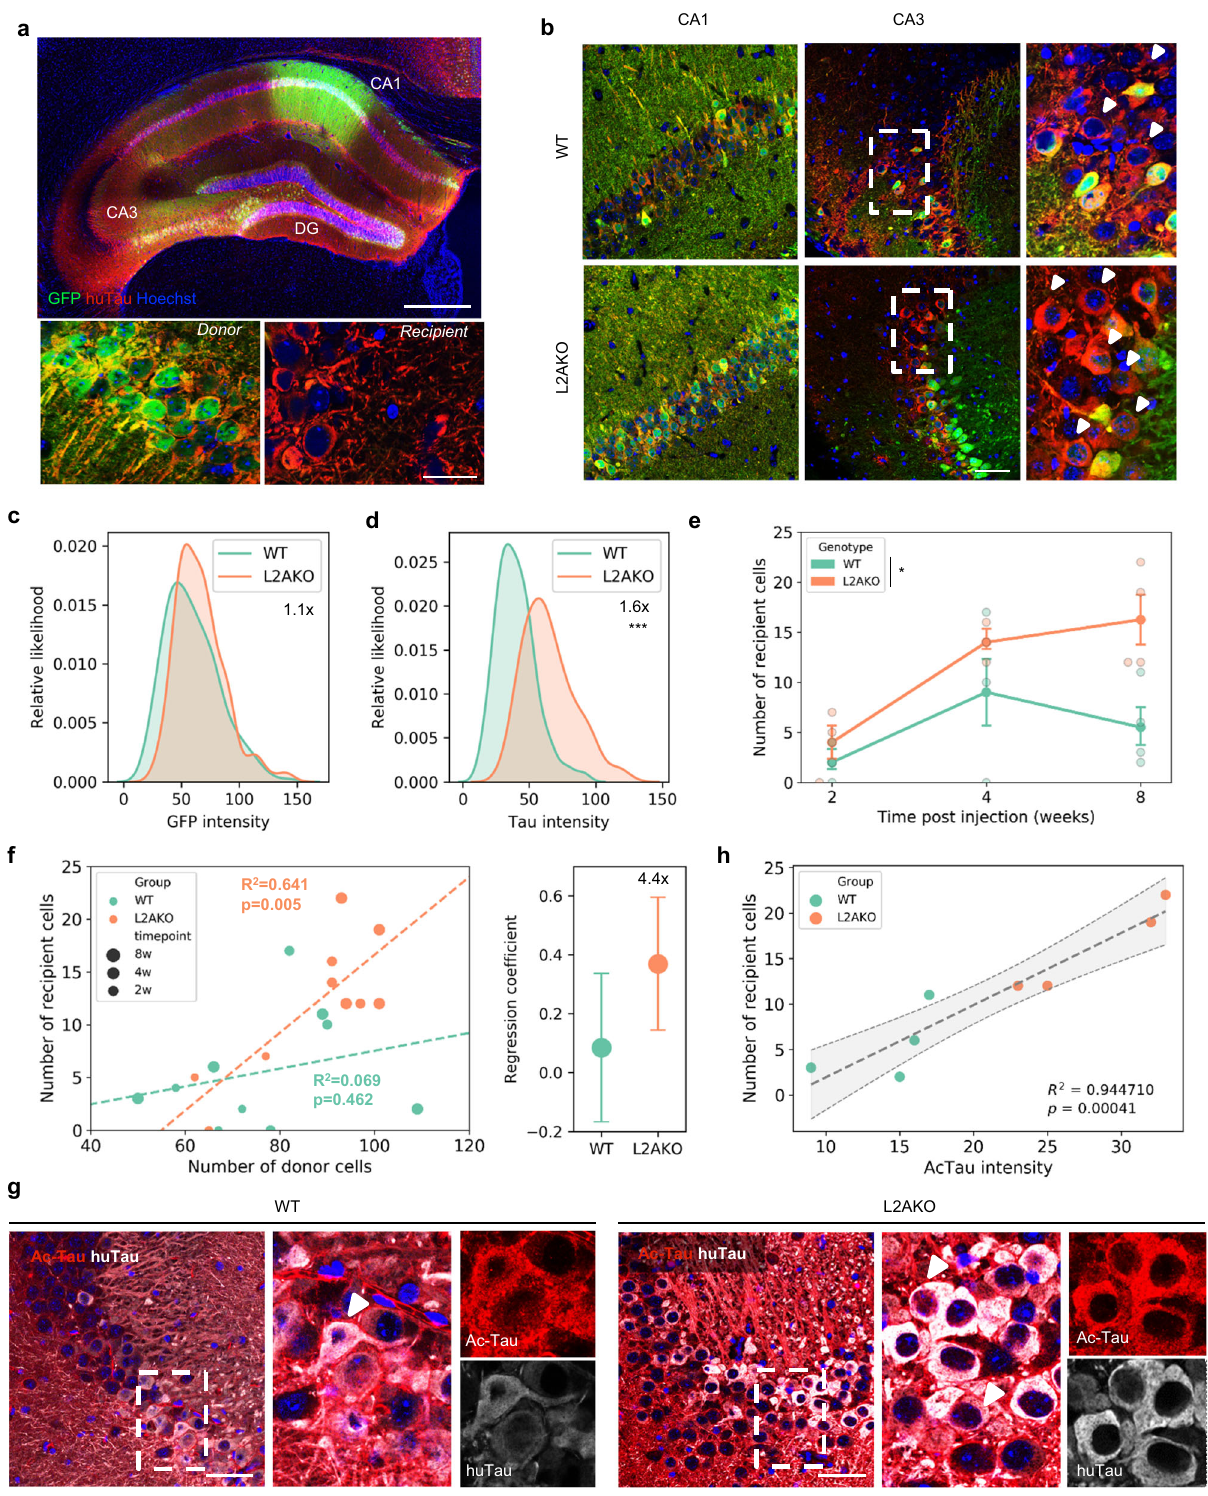
fi ndings showing that levels of speci fi c acetylation on tau (i.e., ac- K174) also differ greatly in different subcellular compartments, to be performed at the subcellular